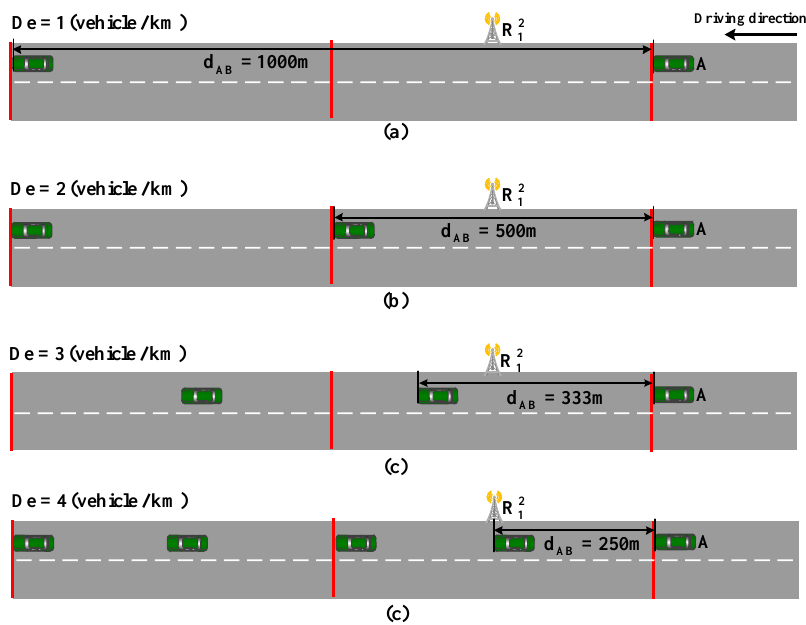
Figure 6. Vehicle distribution considering different vehicle densities: ( a ) De = 1; ( b ) De = 2; ( c ) De = 3; ( d ) De = 4.